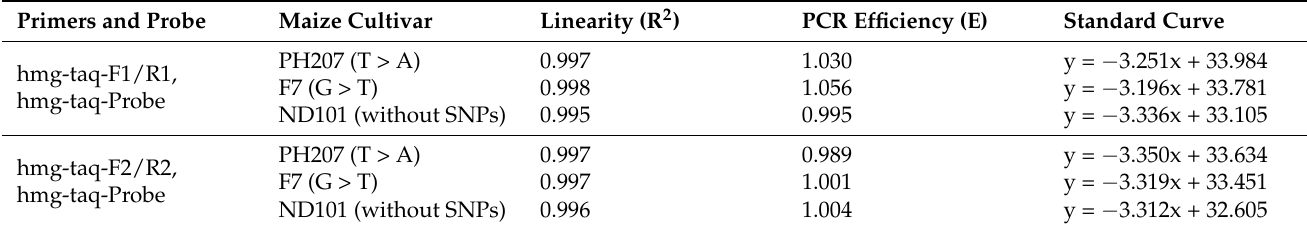
Table 1. PCR efficiency and standard curve linearity of TaqMan assays in their corresponding calibrator lines. Primers and Probe Maize Cultivar Linearity (R 2 ) PCR Efficiency (E) Standard